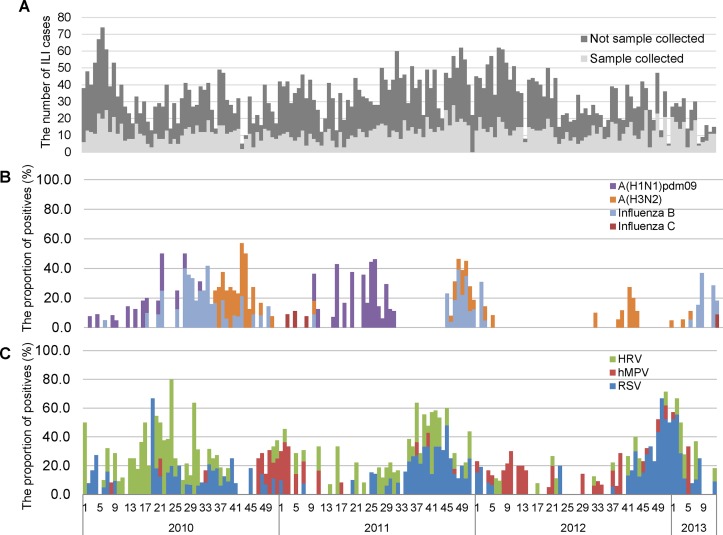
A–C Weekly number of influenza-like illness (ILI) (A), and weekly proportions of influenza positives (B), and virus positives other than influenza (C) from 2010 to 2013.Abbreviations: RSV, respiratory syncytial virus; HRV, human rhinovirus; hMPV, human metapneumovirus